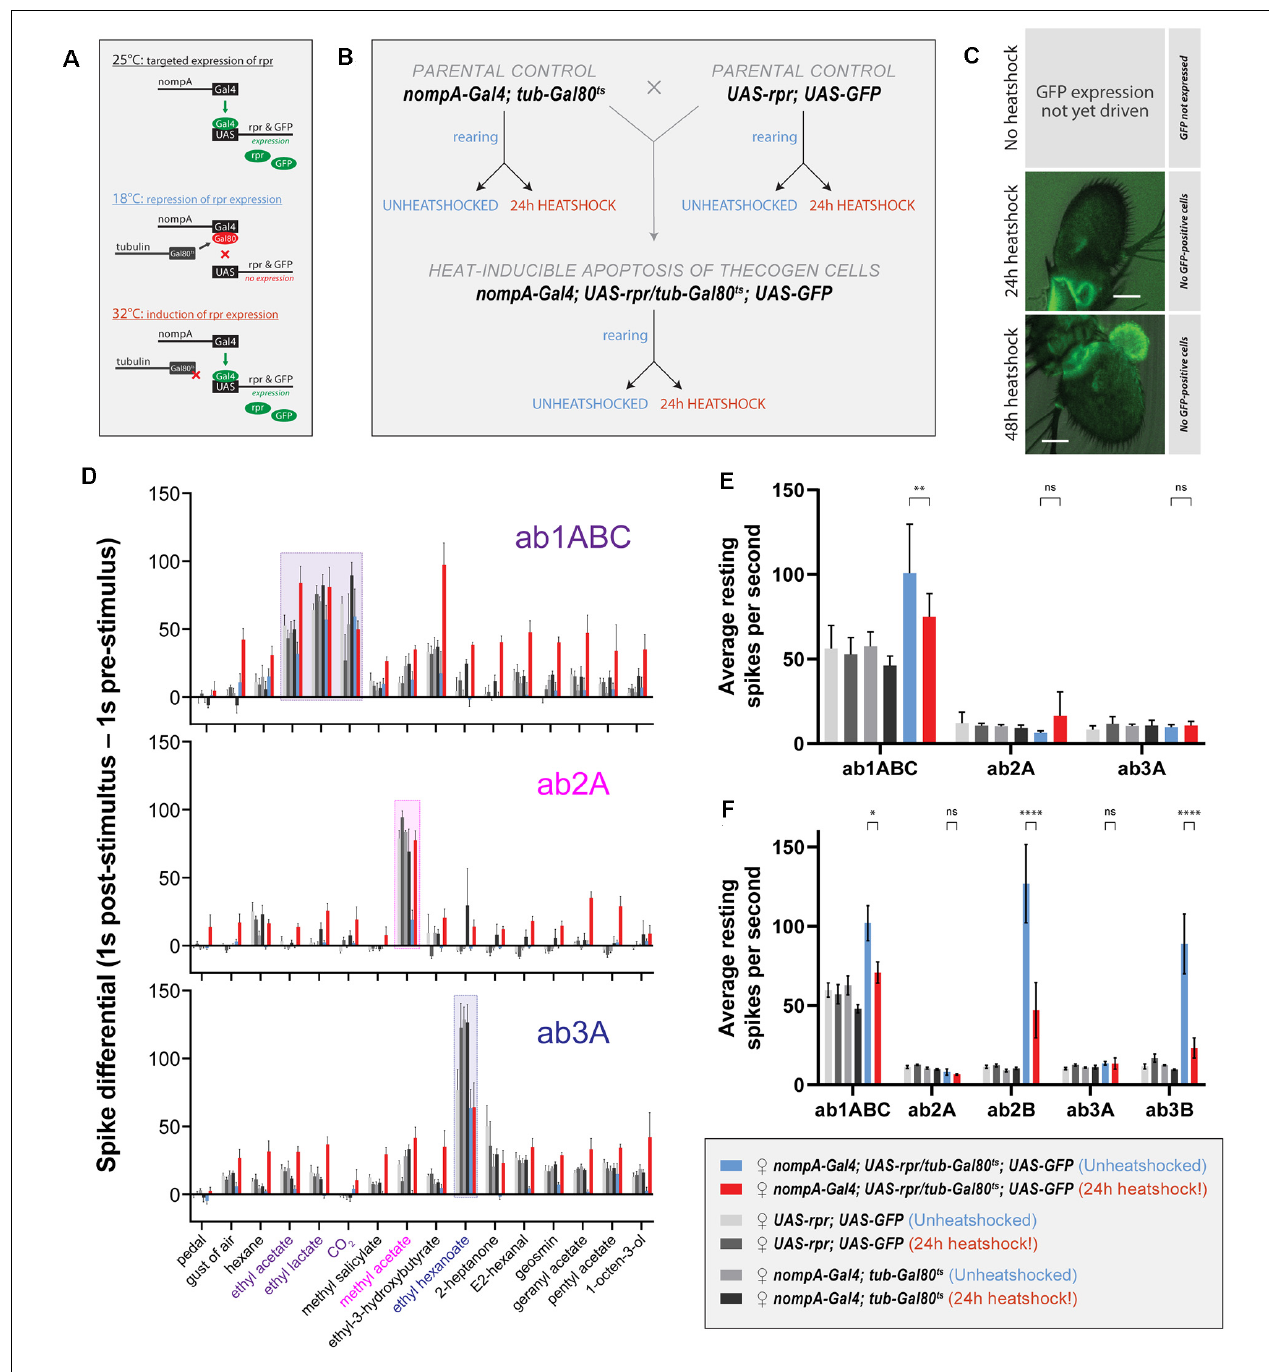
FIGURE 5 | Effects of ablation of thecogen cells in adult flies by apoptosis on in vivo neuron responses to a panel of treatments. (A) Schematic of inducible ablation of thecogen cells by heatshocking using the GAL4/UAS system. (B) Crossing scheme used to generate control flies and thecogen cell-free adult flies. Experimental fly cohorts are split into heatshock and no heatshock conditions, as well as three genotypes, of which two are parental controls. (C) Confocal Z-stack of antennae following a 24 h and 48 h heatshock at 32 ◦ C, showing an absence of GFP signal, indicating complete absence and loss of thecogen cells following heat treatment. (D) Treatment response profile for three sensilla: a sum of spikes in all ab1 neurons excluding the D neuron, spikes of ab2A neuron, and spikes of ab3A neuron. Response profile is calculated by taking a sum total of all spikes 1 s following stimulus onset subtracted from the sum total of all spikes 1 s prior to stimulus onset. (E) Average neuron activity per second measured from a 13 s measurement window during no treatment. Units in resting spikes per second. (F) Average neuron activity per second measured from the sum total of spikes preceding stimulus onset by 1 s. Units in resting spikes per second. Two-way ANOVA with the Tukey post hoc tests were used to compare all sets of data; only some are shown. Asterisks indicate statistical significance ( ns not significant, * p ≤ 0.05, ** p ≤ 0.01, **** p ≤ 0.0001).